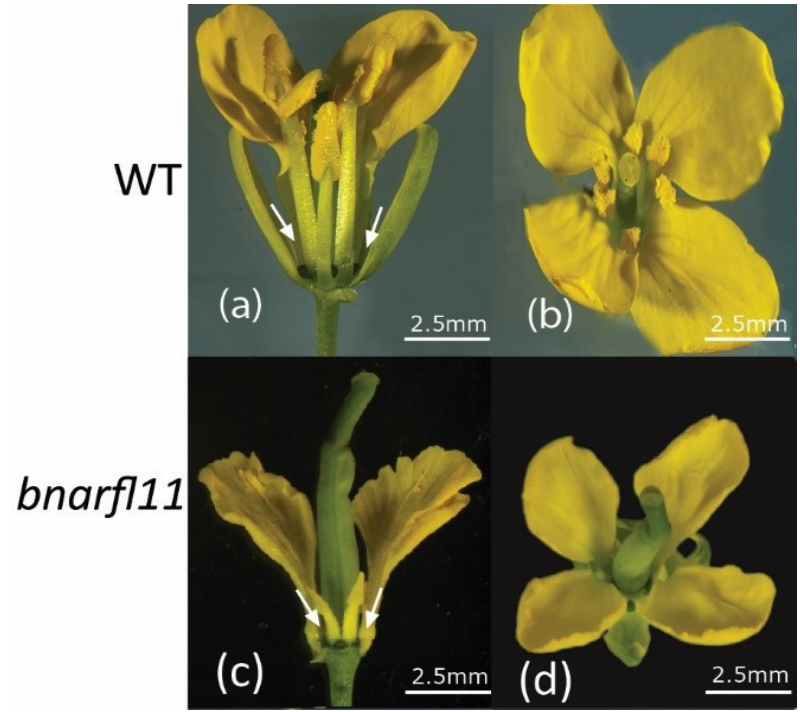
Figure 5. Phenotypic analysis of CRISPR/Cas9 mutated bnarfl11 plants. ( a , b ) Shows wild type with normal flower development. ( c , d ) Shows bnarfl11 flower.